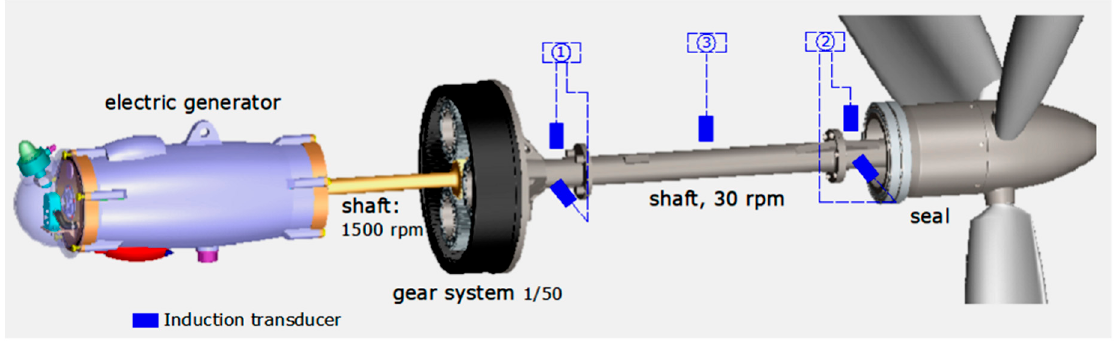
Figure 1. Tidal Turbine